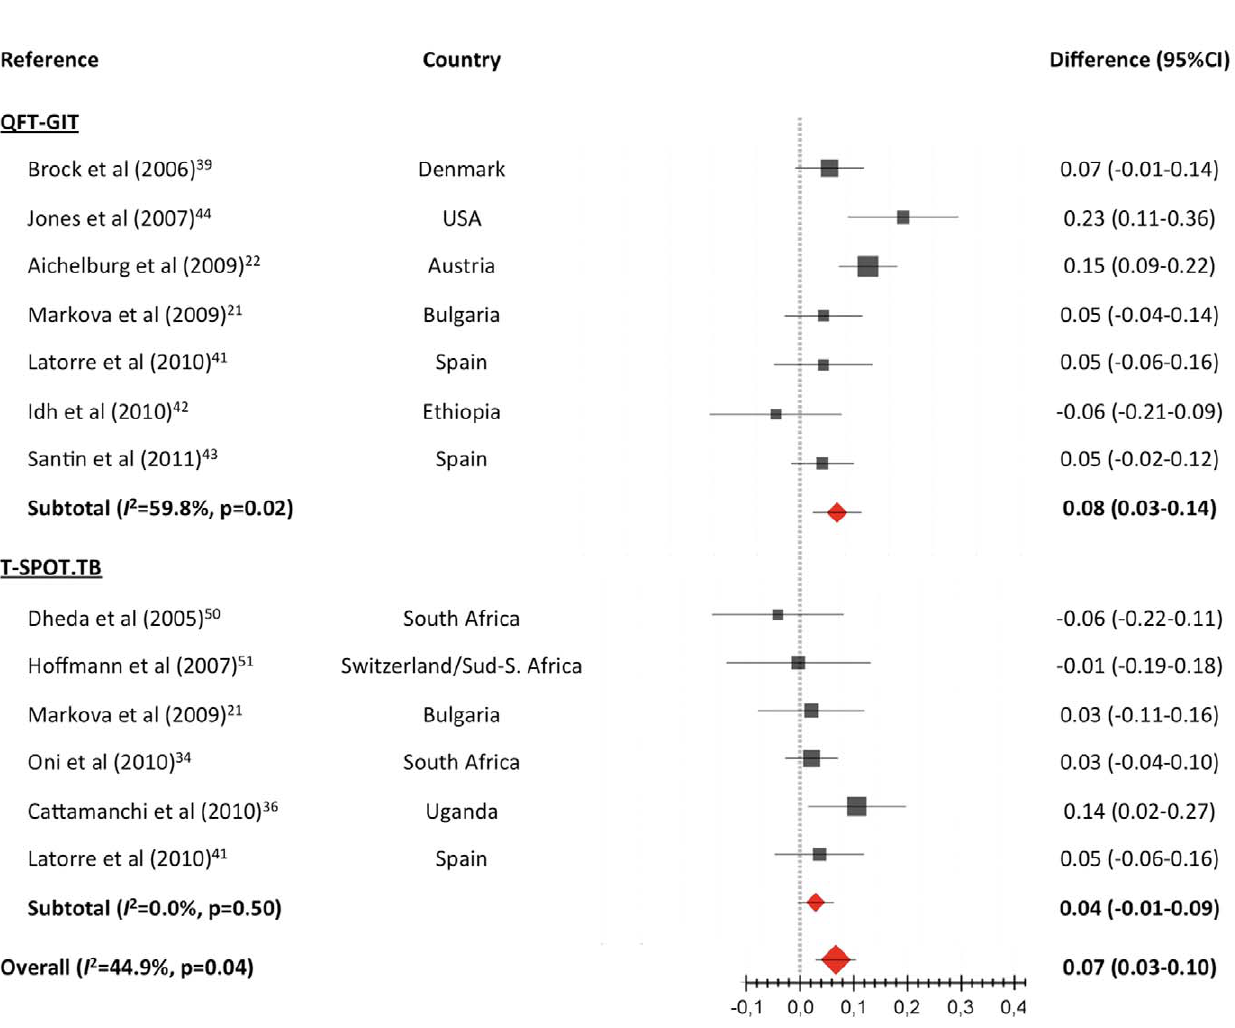
Figure 6. Differences in the proportion of indeterminate results of IGRAs by 200 CD4 + cell count threshold. Pooled estimates derived from random effects (DerSimonian-Laird) modeling.